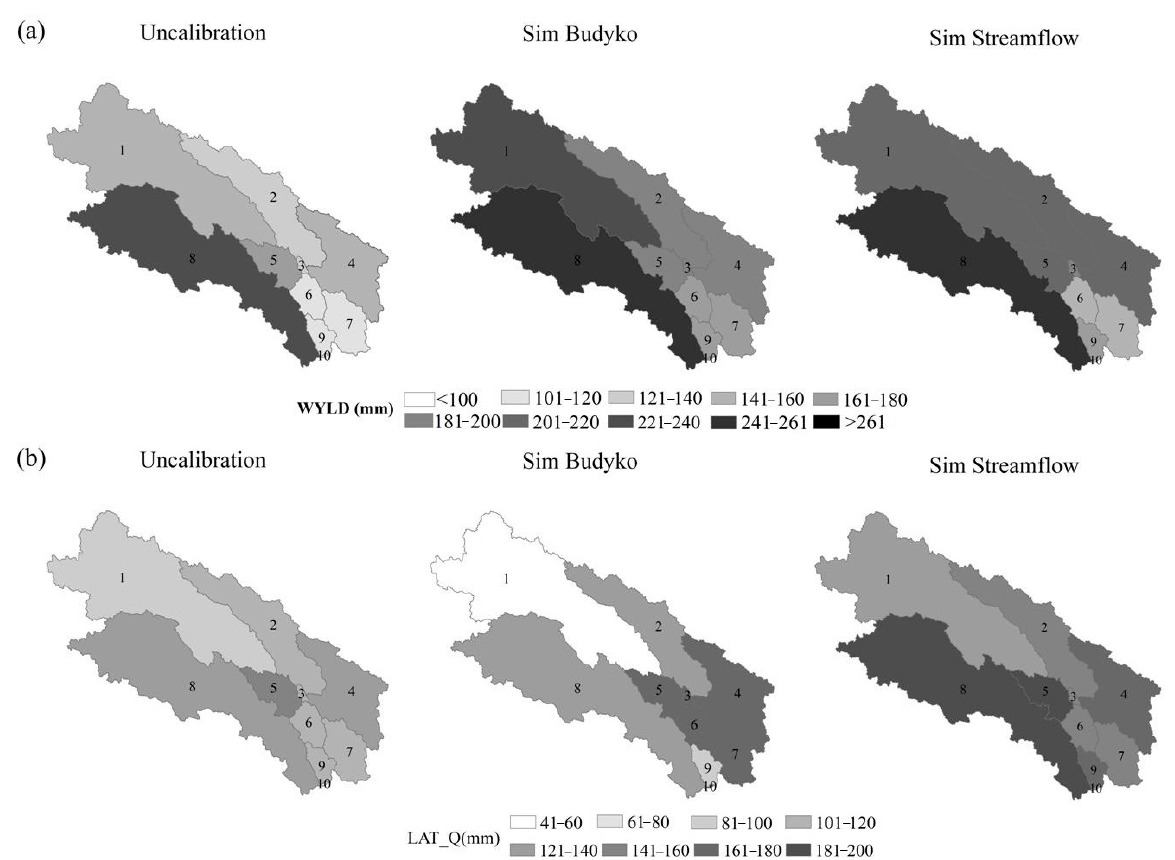
Figure 8. ( a )Lateral flow and ( b )water yield spatial variation of sub-basins for 1961~2013. Numbers represent subbasins code .